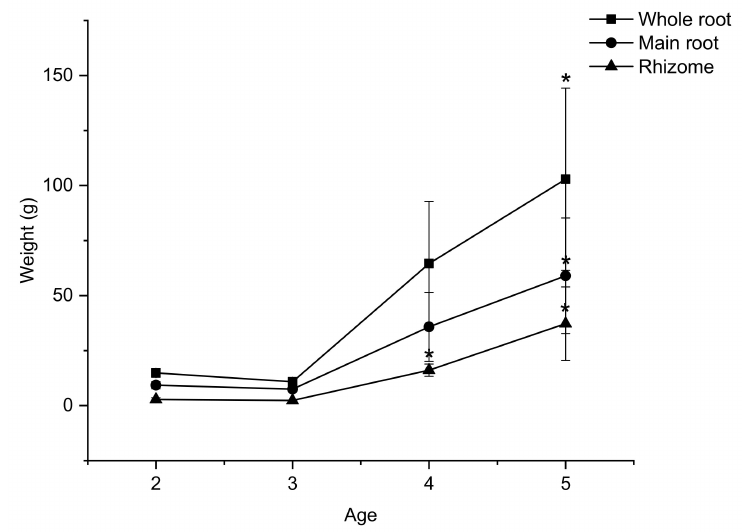
Figure 3. The increase trend weight of VG whole roots, main roots, and rhizomes from 2–5 years. Results are expressed as mean ± SD ( n = 5). * p < 0.05 compared with the age of 2.